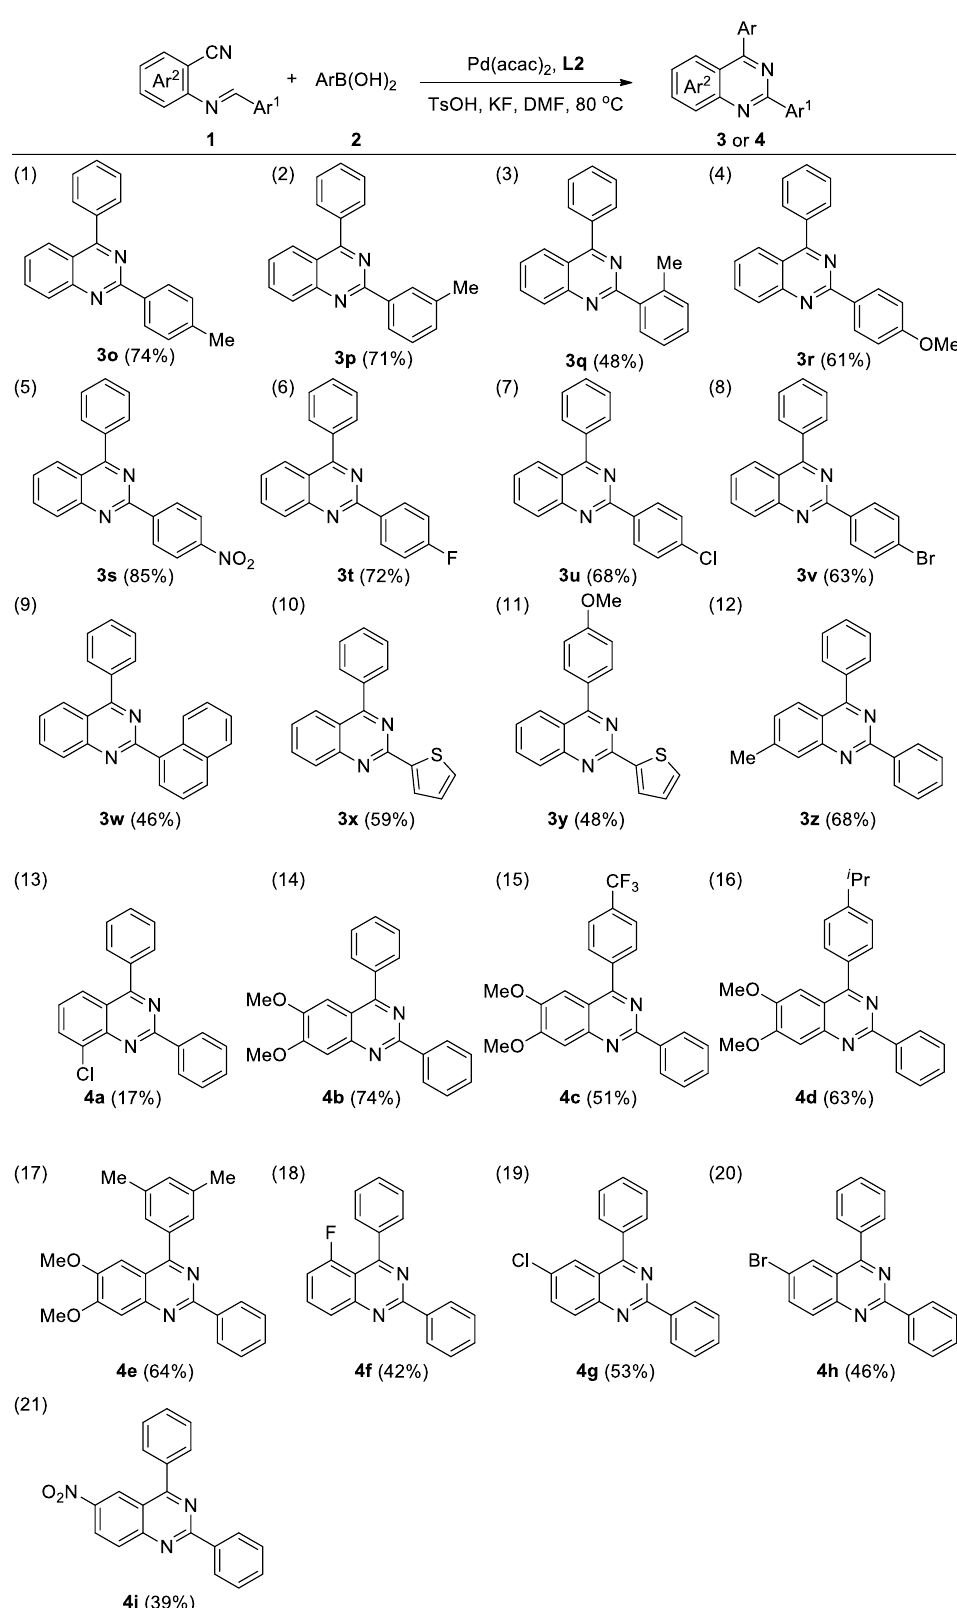
Table 3. Tandem reaction of various 2-(benzylideneamino)benzonitriles with arylboronic acid a